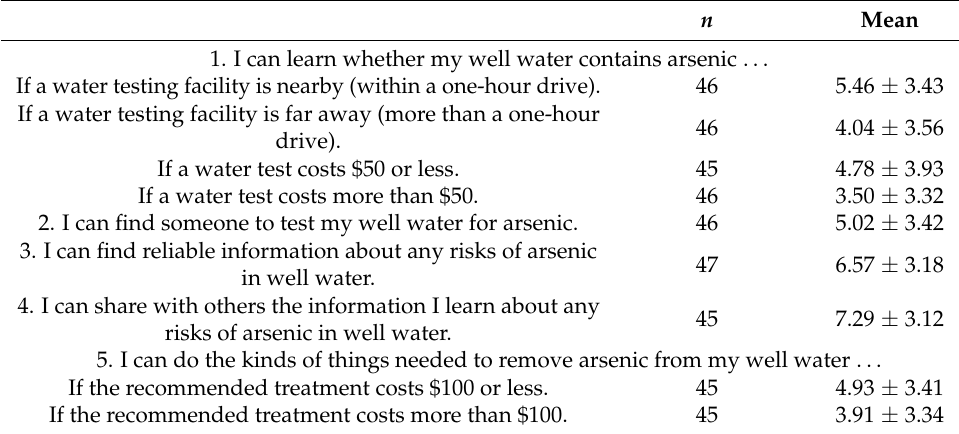
Table 5. Responses to self-efficacy questions.